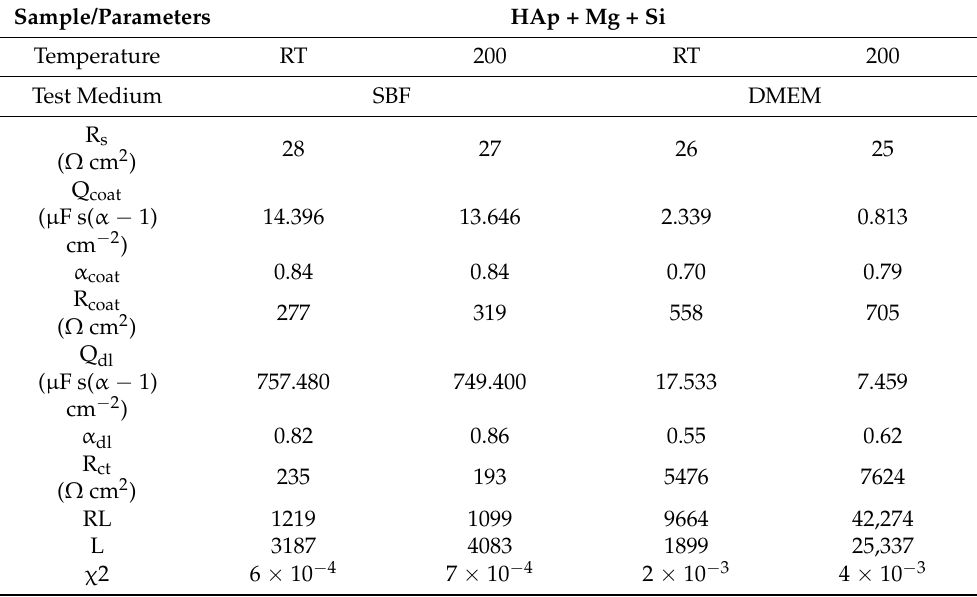
Table 4. EIS fitting results of the coatings obtained in SBF and DMEM solutions.